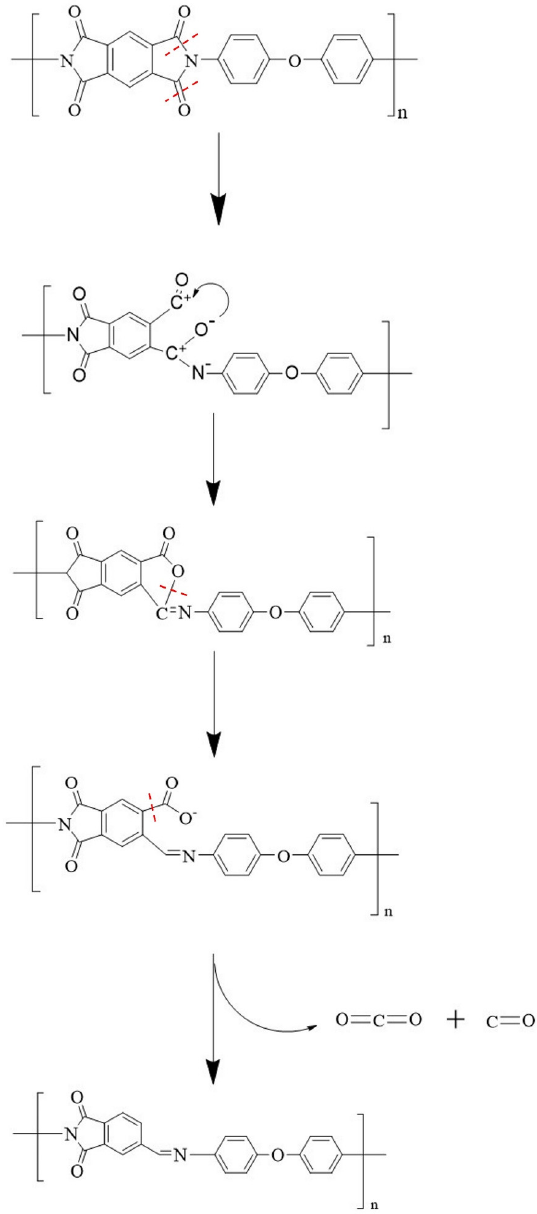
Figure 2. A scheme reporting the chemical decomposition of PI.